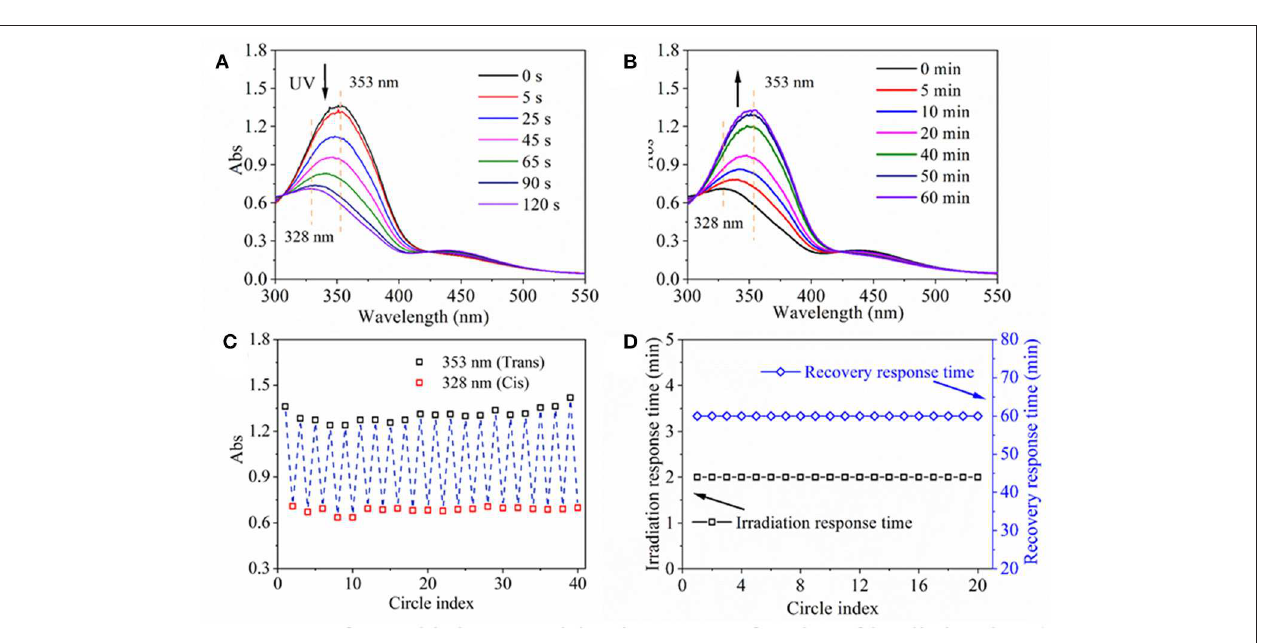
FIGURE 3 | UV spectra of assembled nanoparticle aqueous solution as a function of irradiation time (A) and recovery time (B) . (C) Absorbance at 353 nm/328nm of assembled nanoparticle aqueous solution, and (D) irradiation response time under UV irradiation and recovery response time under 260 µ W/cm 2 white light at room temperature as a function of circle